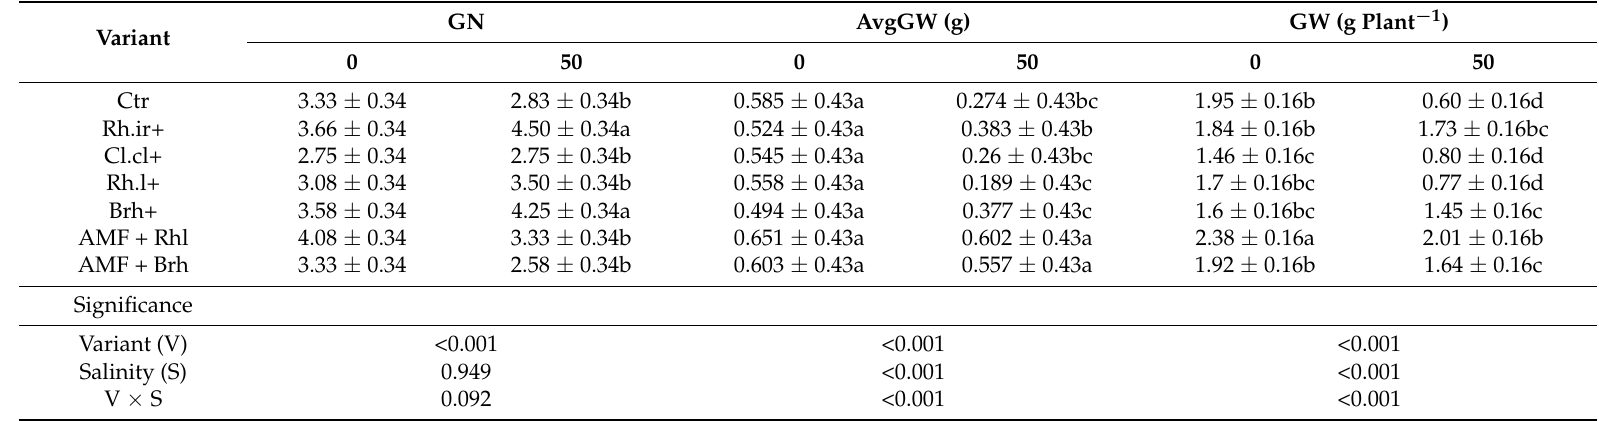
Table 3. Grain number (GN), average weight of fresh grains (AvgGW; g), and total fresh grain weight (GW; g plant − 1 ) of control (Ctr), Rhizophagus irregularis —inoculated (Rh.ir+), Claroideoglomus claroideum —inoculated (Cl.cl+), Rhizobium leguminosarum —inoculated (Rh.l+), Burkholderia spp.—inoculated (Brh+), Rhizophagus irregularis + Claroideoglomus claroideum + Rhizobium leguminosarum —inoculated (AMF+Rhl), and Rhizophagus irregularis + Claroideoglomus claroideum + Burkholderia spp.—inoculated (AMF + Brh) pea plants under two levels of salinity (0 and 50 mM NaCl). Different letters indicate significant differences within following parameters (Tukey test, p < 0.05; mean ±